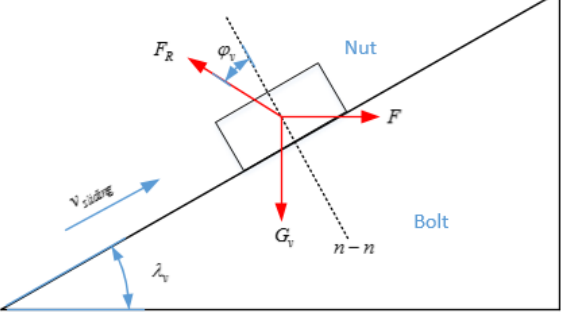
Figure 3. Kinematic relationship between screw and nut during tightening.